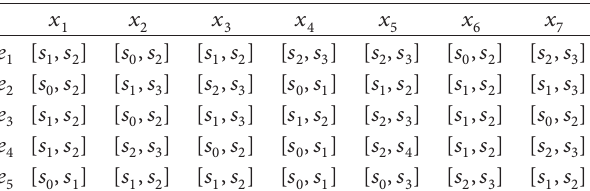
Table 1: The decision makers’